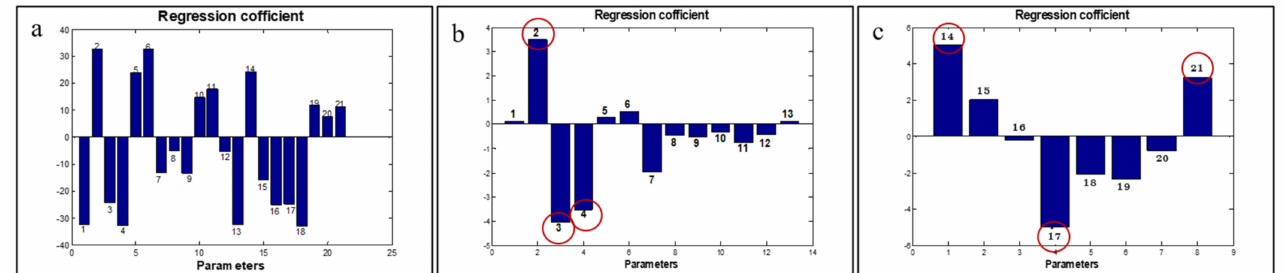
Figure 5. The corresponding PLS values of the impact of physiological and proximate characteristics on DE ( a ); the corresponding PLS values of the impact of physiological properties on DE ( b ); the corresponding PLS values of the impact of proximate compositions on DE ( c ). Physiological properties of mango fruit were %peel (1), %flesh (2), %seed (3), %total biomass (4), L* (5), a* (6), b*(7), D g (8), D a (9), R a (10), Φ (11), surface area (12), and peel-to-fruit ratio (13); the proximate compositions were crude fiber (14), crude protein (15), crude lipid (16), moisture content (17), ash (18), carbohydrate (19), fructose (20), and xylose (21). The bar graphs of each parameter indicate positive and negative impacts on DE